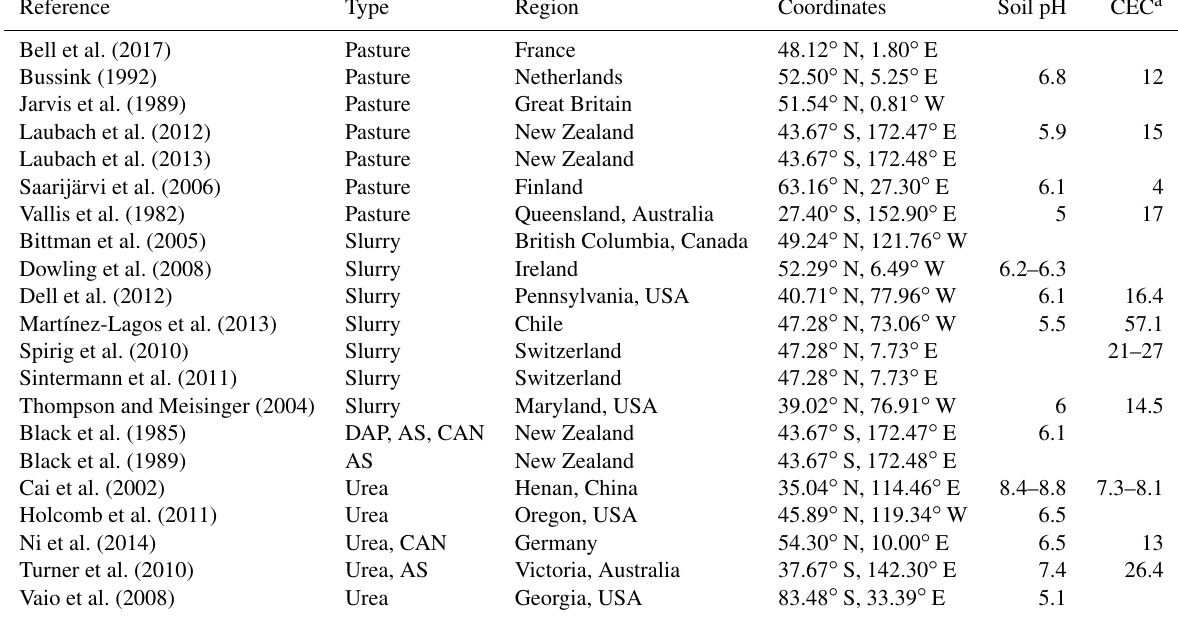
Table B1. Experimental studies used in model evaluation (Sect. 2.6). Soil pH and cation exchange capacity are shown when reported. The synthetic fertilizers are abbreviated as AS (ammonium sulfate), CAN (calcium ammonium nitrate), and DAP (diammonium phosphate). The measurements of Bittman et al. (2005) and Dowling et al. (2008) were extracted from the ALFAM2 database (Hafner et al., 2018).